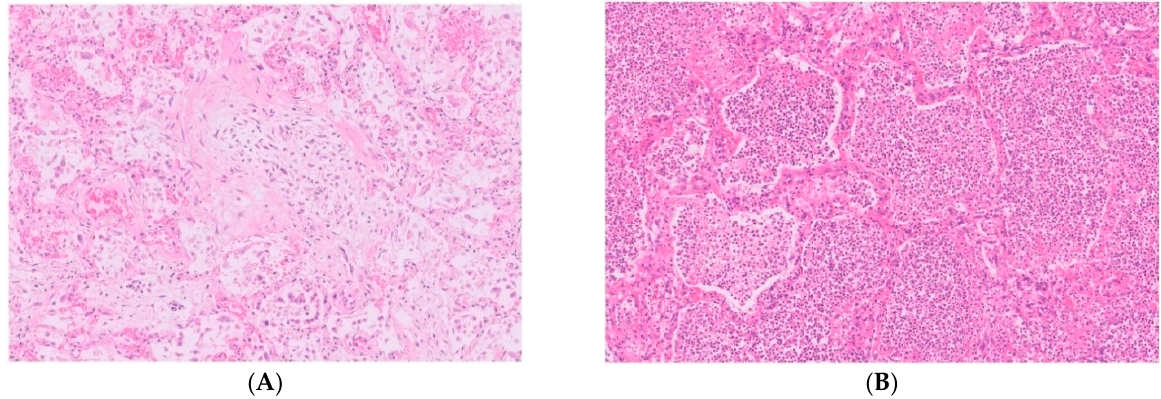
Figure 2. ( A , B ). Histological examination (hematoxylin and eosin, x100) of the lung parenchyma shows profound conges- tion, edema, interstitial inflammation and fibroblastic proliferation ( A ), and sampling from the abscesses shows large col- lections of neutrophils inside the alveolar spaces ( B ).